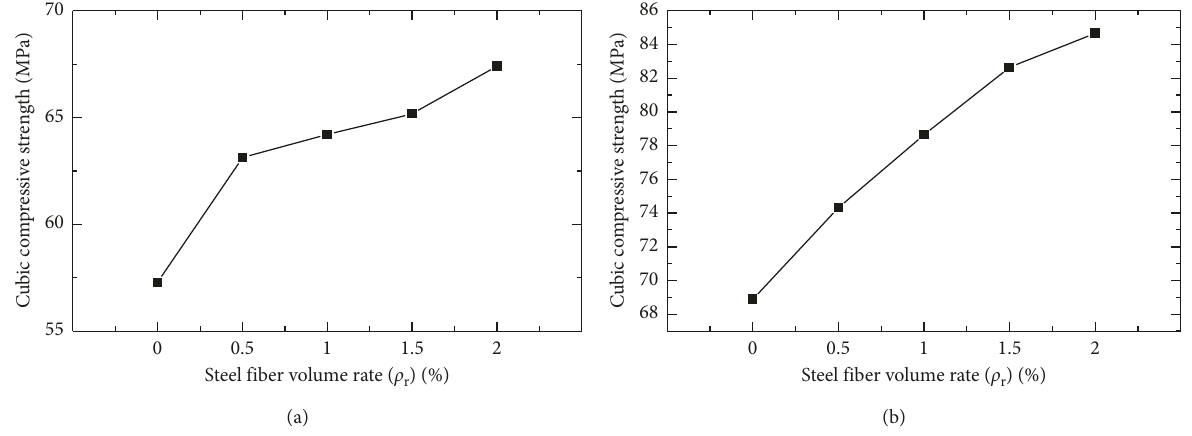
Figure 9: Relationship between cube compressive strength and steel fiber content. (a) CF50; (b) CF60.